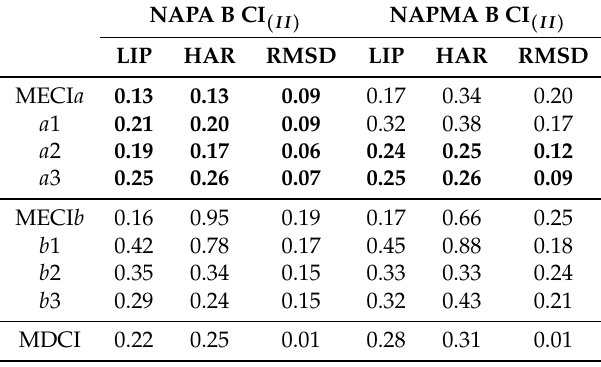
Table 4. Energies (in eV) of a set of ππ ∗ / n π ∗ conical intersection (CI) geometries of NAPA B and ( II ) NAPMA B relative to corresponding M ππ ∗ minimum. Included are minimum energy CI (MECI), minimum distance CI (MDCI) and CI points obtained by linear interpolation (LIP) between M ππ ∗ and six M n π ∗ minima. Relative energies calculated assuming a harmonic approximation for the ππ ∗ ( II ) surface (HAR) and RMSD (Å) between CI and M ππ ∗ structures. Classically-accessible geometries are given in